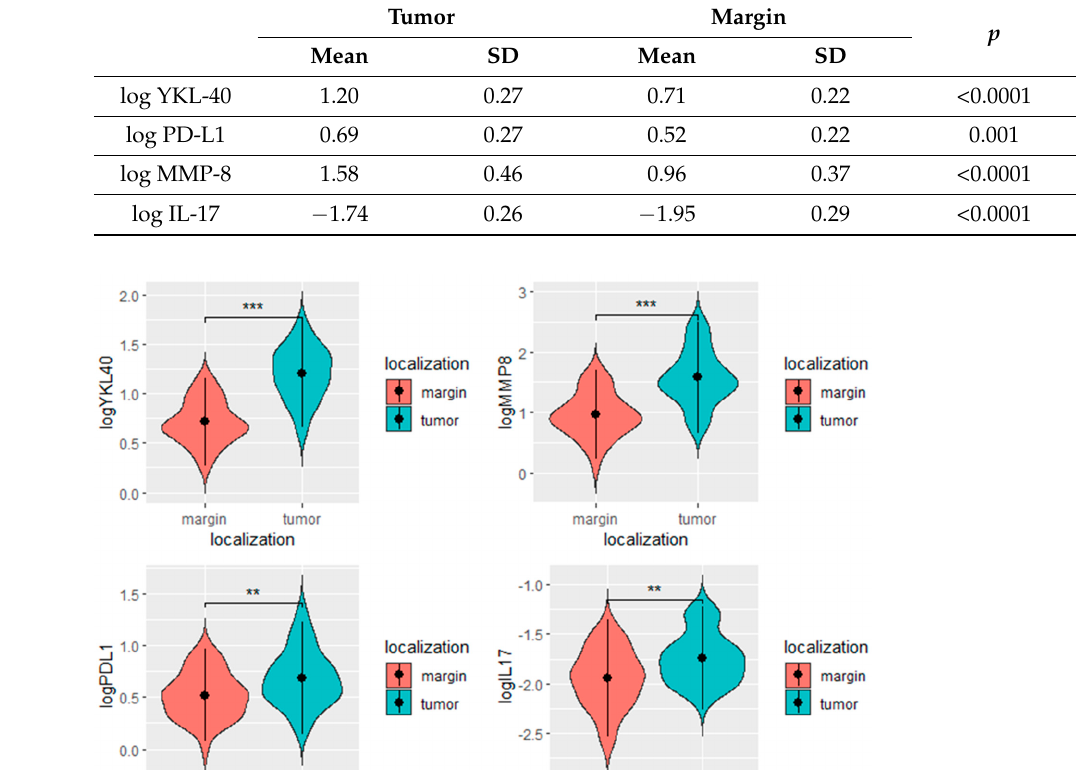
Table 2. Levels of YKL-40, PD-L1, MMP-8, IL-17, and IL-23 proteins in tumor and margin presented as log-transformed ng/mg of protein. Paired Student’s t -test.